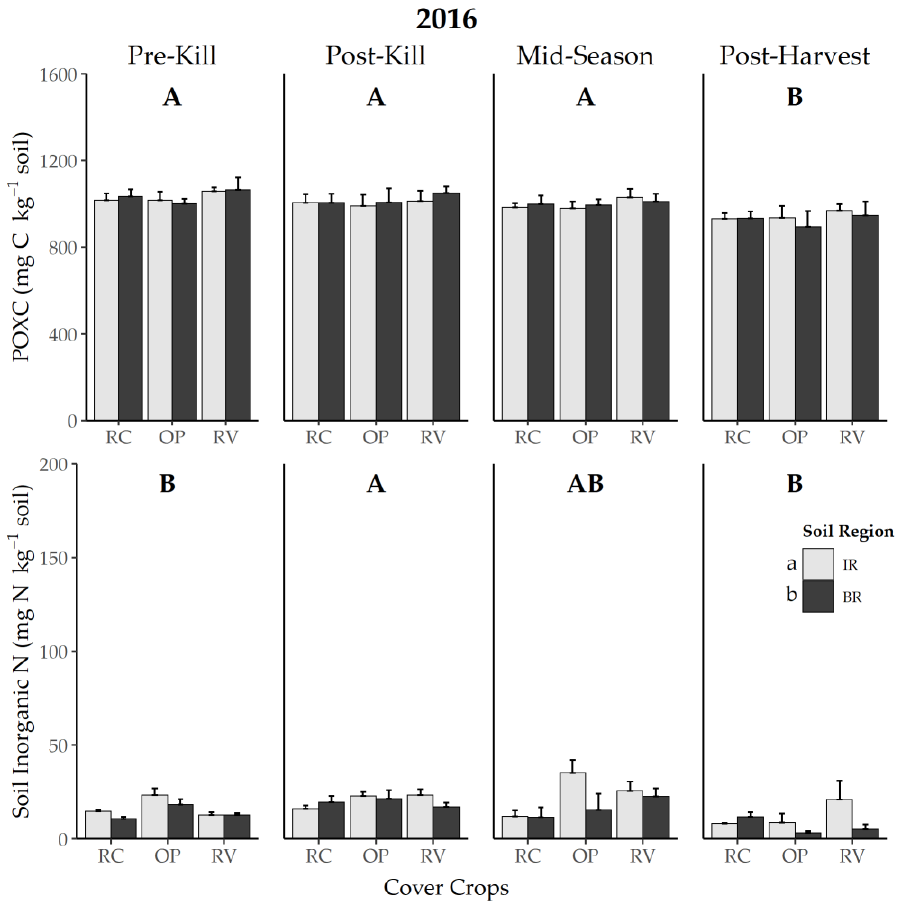
Figure 2. Effect of soil region and cover crop system on permanganate oxidizable C (POXC) and soil inorganic N in 2016 at four sampling times. Error bars represent one standard error. Different capital letters between panels represent a difference between sampling times at p < 0.05, and different lowercase letters between soil regions represent a difference at p < 0.05 for soil inorganic N. OP = oat + field pea, RV = winter rye + hairy vetch, RC = medium red clover. IR = in rows, BR = between rows.